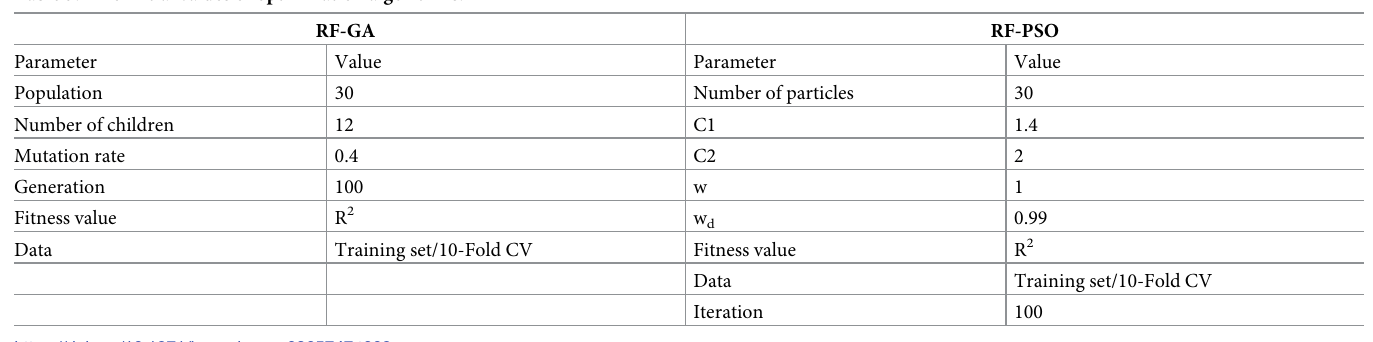
Table 3. The initial values of optimization algorithms.